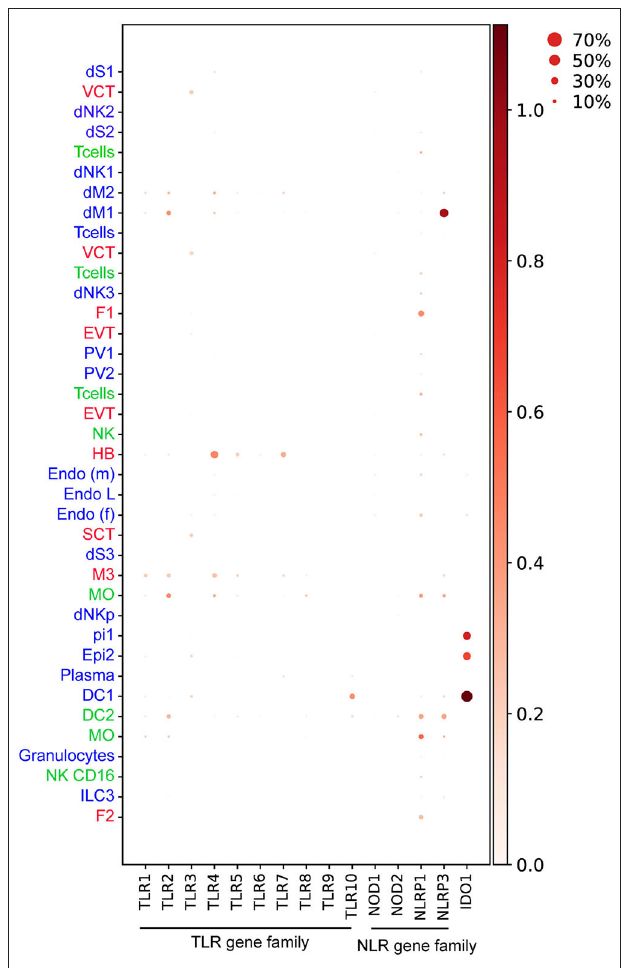
FIGURE 4 | Dotplot representing normalized and log transformed values expression of TLR ( TLR1-10 ), NLR genes ( NOD1, NOD2, NLRP1, NLRP3 ) and IDO1 at steady state in early pregnancy from Vento-Tormo et al. (10). Origin of cell types from placenta (red), decidua (blue), and maternal blood (green) are labeled as differences in font color. Dot size represents the fraction of cells from a certain cluster expressing a gene and color scale represents normalized log transformed expression of the gene in that cluster. dS, decidua stroma; F, fibroblast; MO, monocyte; Endo, endothelial; Epi, epithelial; SCT, syncytiotrophoblast; VCT, villous cytotrophoblast; EVT, extravillous trophoblast; DC, dendritic cell; dNK, decidua Natural killer cells; dM, decidua macrophages; HB, Hofbauer cell; PV, perivascular cells. Figure is created by